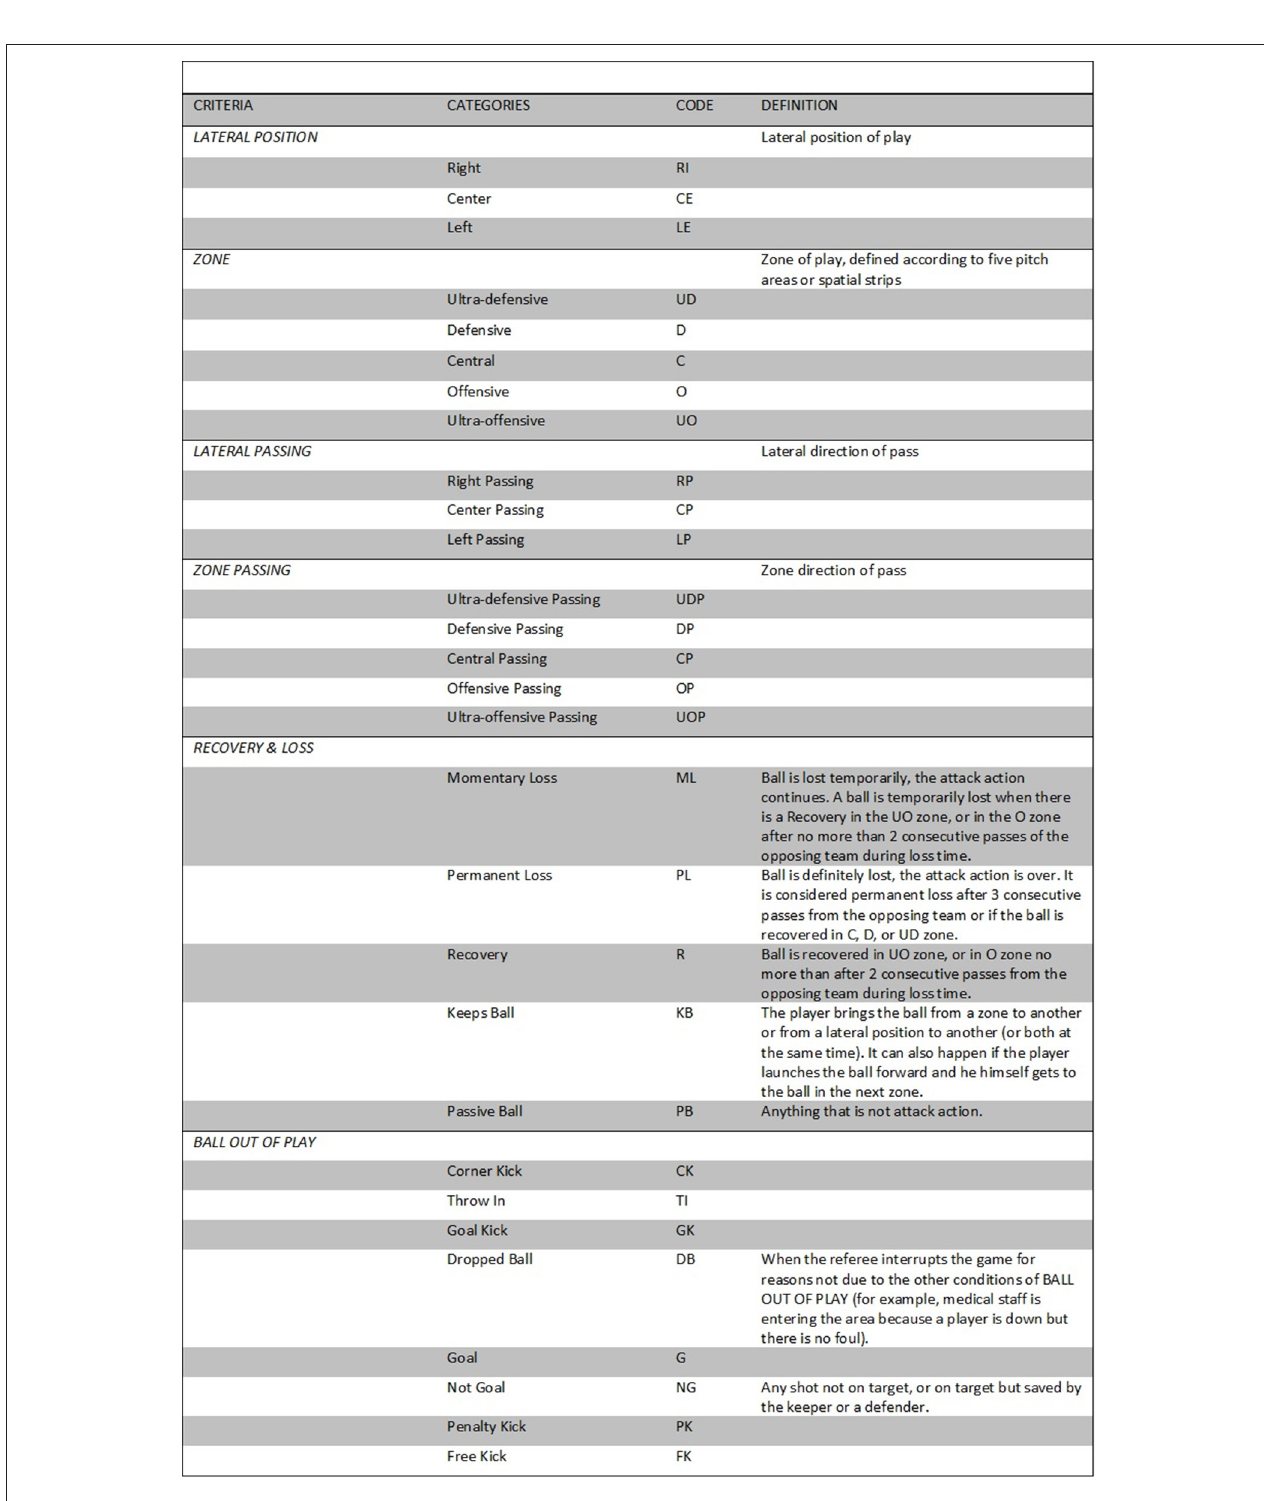
FIGURE 1 | Observation